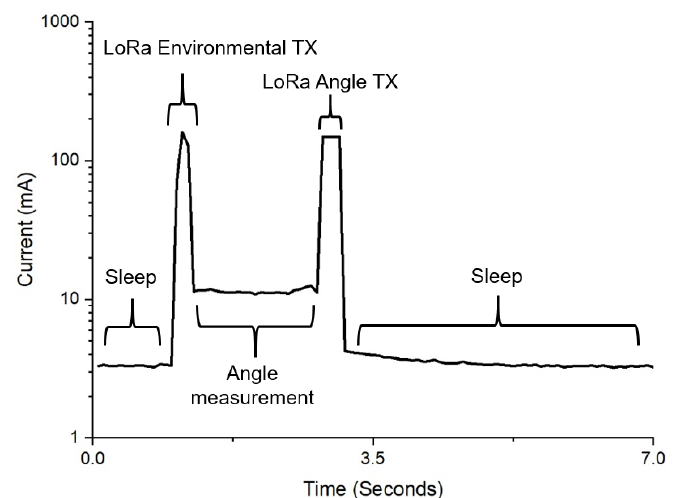
Figure 10. A comparison of the power and current provided by one or two solar panels at different light exposure levels with the idle power consumption of the system in each configuration.